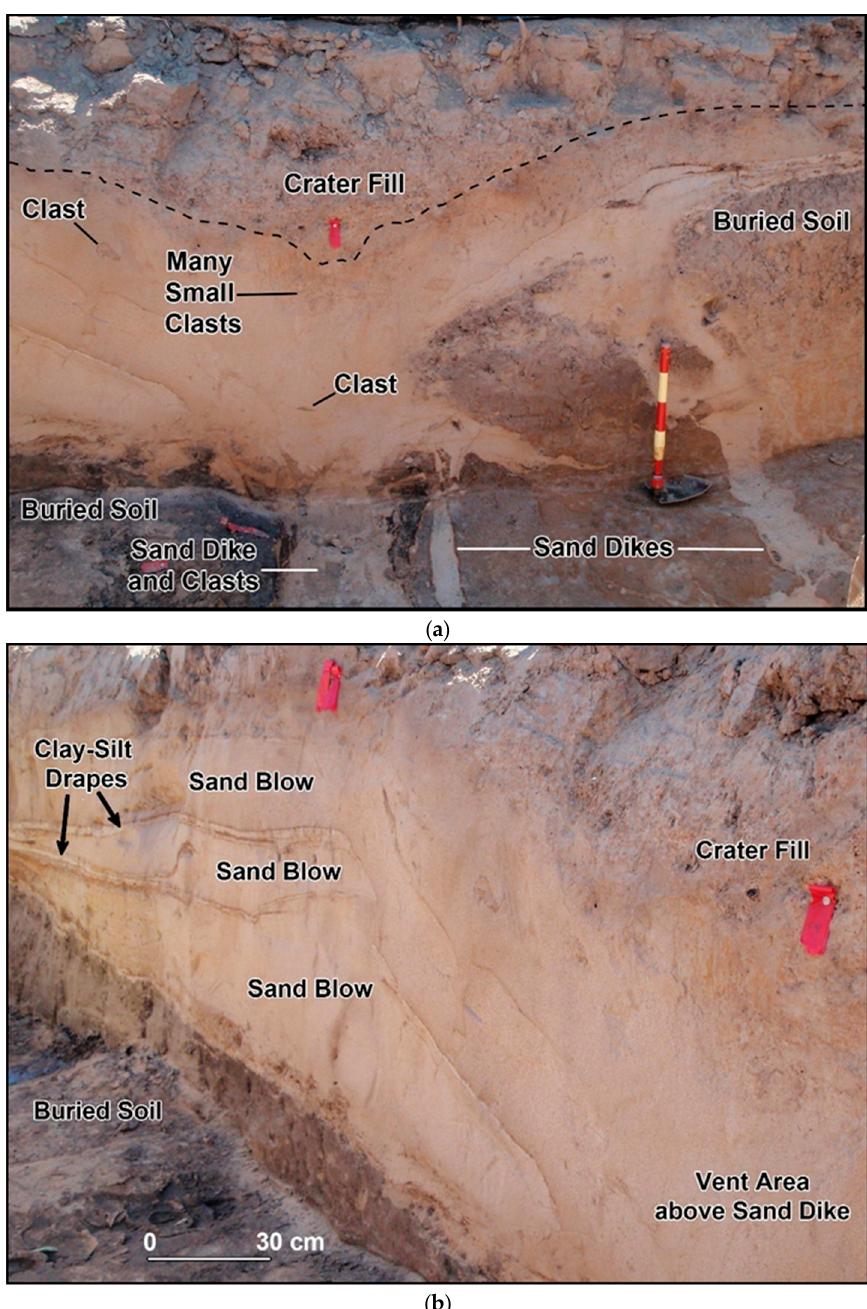
Figure 5. A compound sand blow that formed during the 1811–1812 New Madrid earthquake sequence as exposed in a paleoseismic trench near Blytheville, Arkansas [116]. Photographs by M. Tuttle. ( a ) Vent area of sand blow and related dikes. Brown soil horizon is crosscut by two sand dikes, displaced downward ~1 m, and buried by the sand blow. Clasts of the soil horizon occur within dikes and the overlying sand blow. Each colored interval on shovel handle represents 10 cm. ( b ) Sand blow is composed of three sandy depositional units with the lower two units capped by clay–silt drapes. The top of the upper unit was subjected to soil-forming processes, whereas the lower two units were protected and preserved by the upper unit.